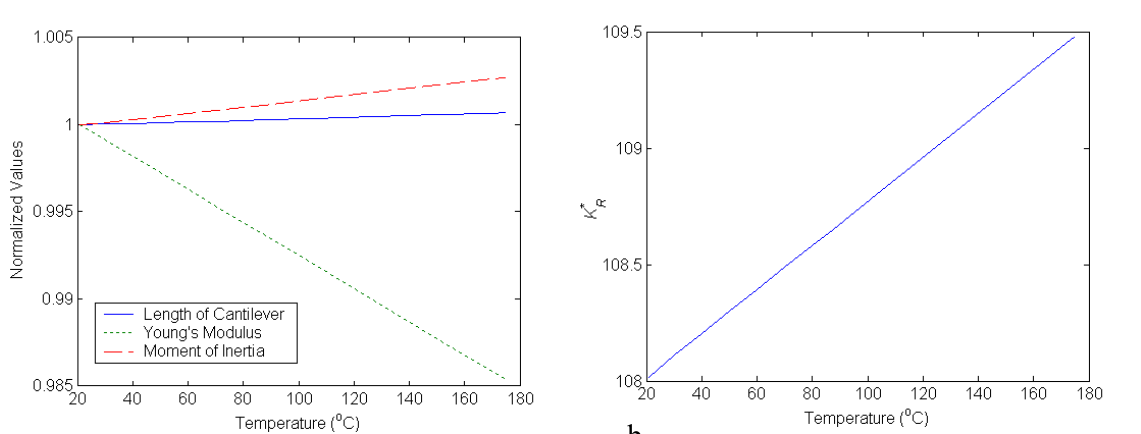
a b Figure 6. a) The normalized variation of length, Young’s modulus of elasticity and moment of inertia for an AFM cantilever as a function of temperature. b) The change in the K R* value as a function of